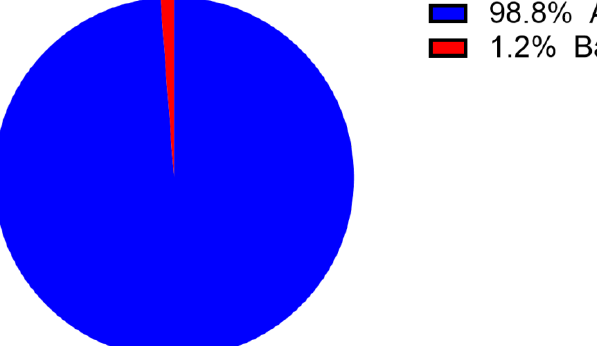
Figure 19. Different classes of metabolites reported in this review.